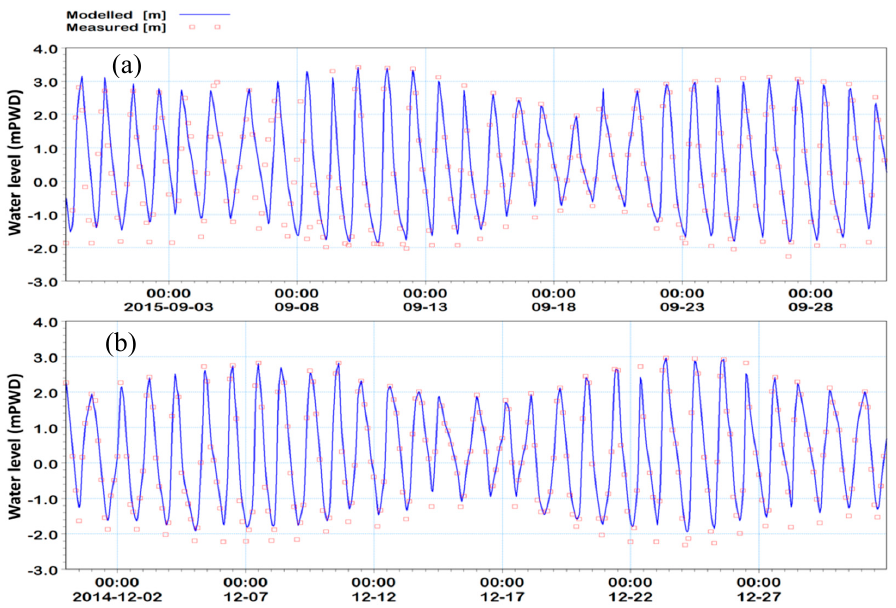
Figure 4. An example of comparison of modelled and measured tidal water level at Noapara in the Betna River. ( a ) represents a wet month (September 2015), and ( b ) represents a dry month (December 2014).